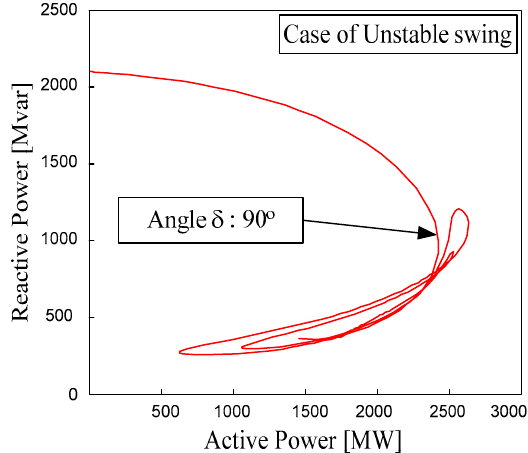
Energies 2020 , 13 , x FOR PEER REVIEW Figure 11. The trajectory of complex power in a complex plane (the fault clearing time is 10 cycles).